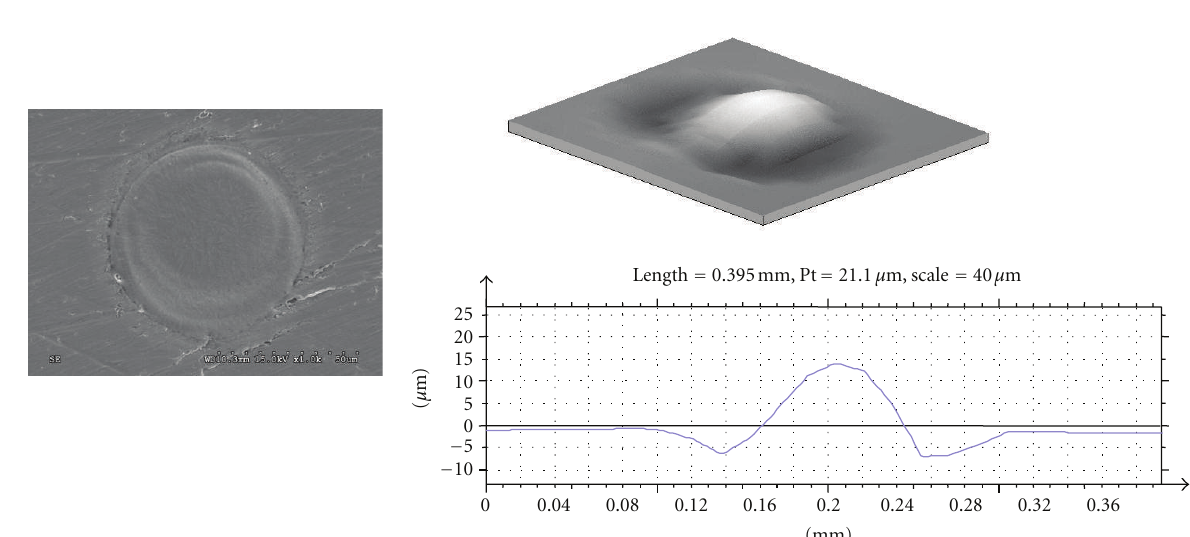
Figure 2: SEM image of individual discharge trace during the EDA on the machined surface, its 3D view and profilogram for U = 160V, I = 8A, Ti = 50 μ